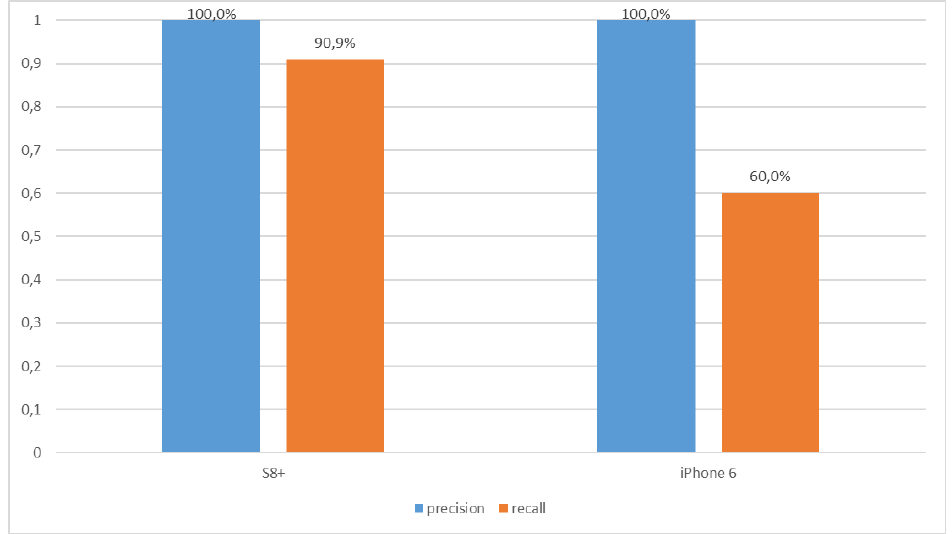
Figure 3. Precision and recall rates by the smartphone used to obtain the images.